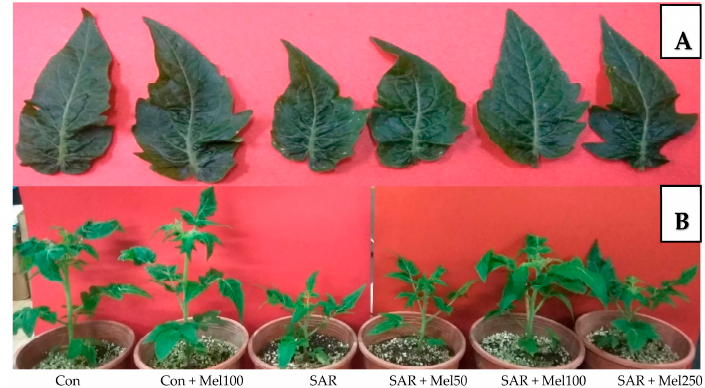
Figure 2. Phenotypic changes of tomato plants in SAR and/or melatonin treatments. ( A ) Leaf phenotype; ( B ) plant phenotype.